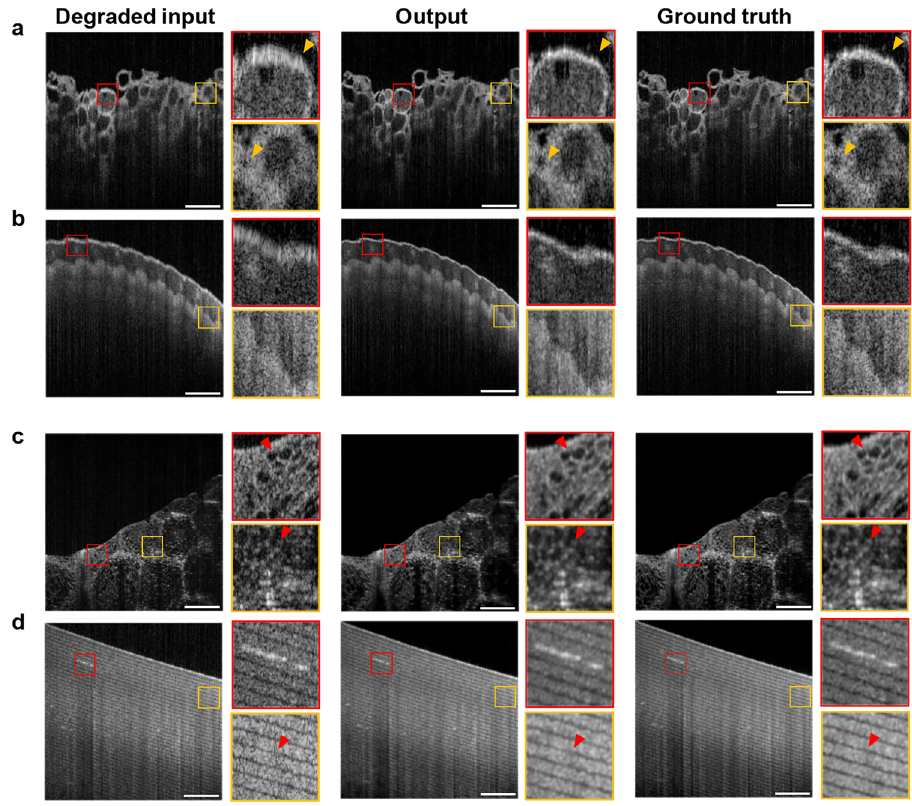
Fig. 2 Individual test performance of both models on degraded input data. Example result of NetA with samples of a thyroid tissue and b fi nger. Example result of NetB with samples of c lemon and d Scotch tape. The degraded input, output, and ground truth images are shown in the three columns. The ROIs (red and yellow boxes) on the right side of the image show magni fi ed views (5X). Scale bars, 1 mm.